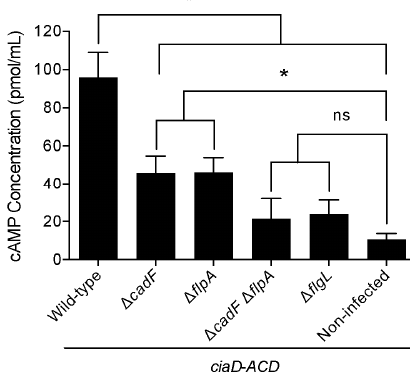
Figure 9. E ffi cient delivery of the C. jejuni CiaD e ff ector protein to host cells requires the CadF and FlpA adhesins. A C. jejuni wild-type strain, ∆ cadF mutant, ∆ flpA mutant, ∆ cadF ∆ flpA mutant, and ∆